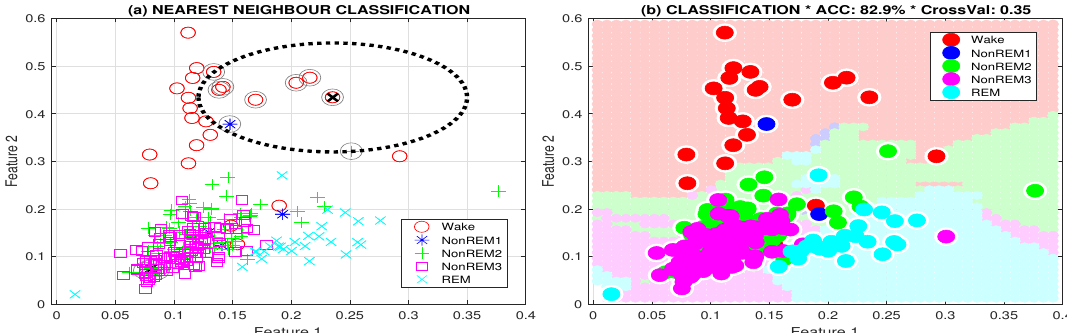
Figure 4. Classification of sleep stages presenting ( a ) class selection for the 5-nearest neighbour method and ( b ) class boundaries of the computational model and two features evaluated as the mean power in selected frequency ranges (1–4 Hz, 4–8 Hz). Table 4. Comparison of the accuracy and cross-validation for classification of sleep features evaluated during the two-hour long observation and 30 s long time windows by the neural network, nearest neighbour, and decision tree